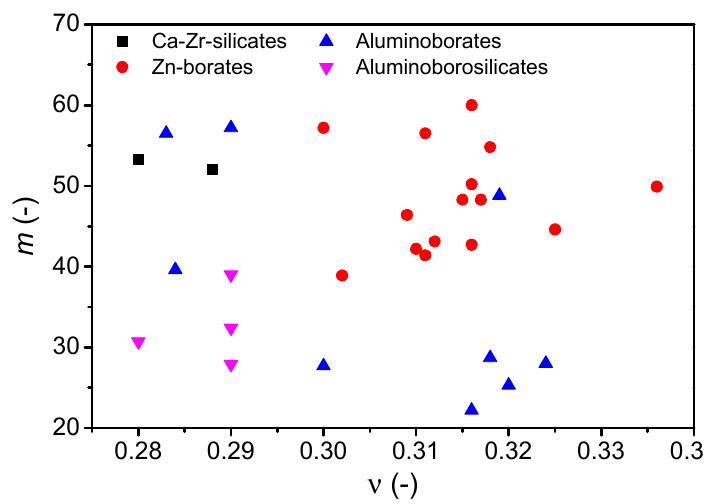
Figure 4. Liquid fragility ( m ) for selected oxide glass-forming systems from this study (Table 1) plotted as a function of Poisson’s ratio ( ν ). No apparent correlation between m and ν is observed. The errors associated with m and ν are 1 and 0.01, respectively. R 2 value for a linear fit to the data is 0.034.